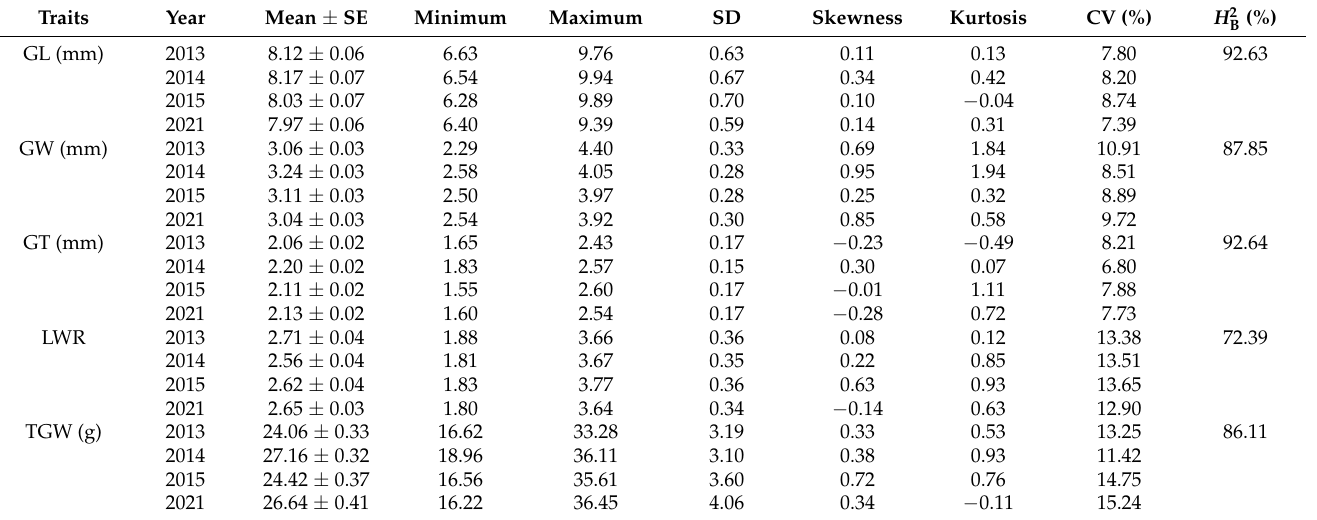
Table 2. Descriptive statistics and heritability in a broad sense for grain-size traits in rice.